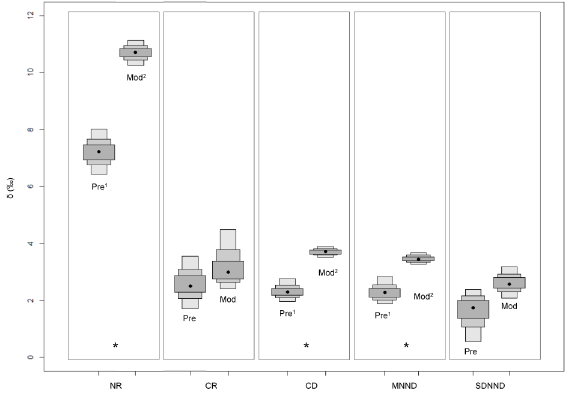
Figure 3. Probability values of Layman’s metrics over the time in the central-northern Patagonia. Metrics that present differences over the time are indicated by an asterisk and superscripts. Pre=pre- contact period; Mod= modern period.